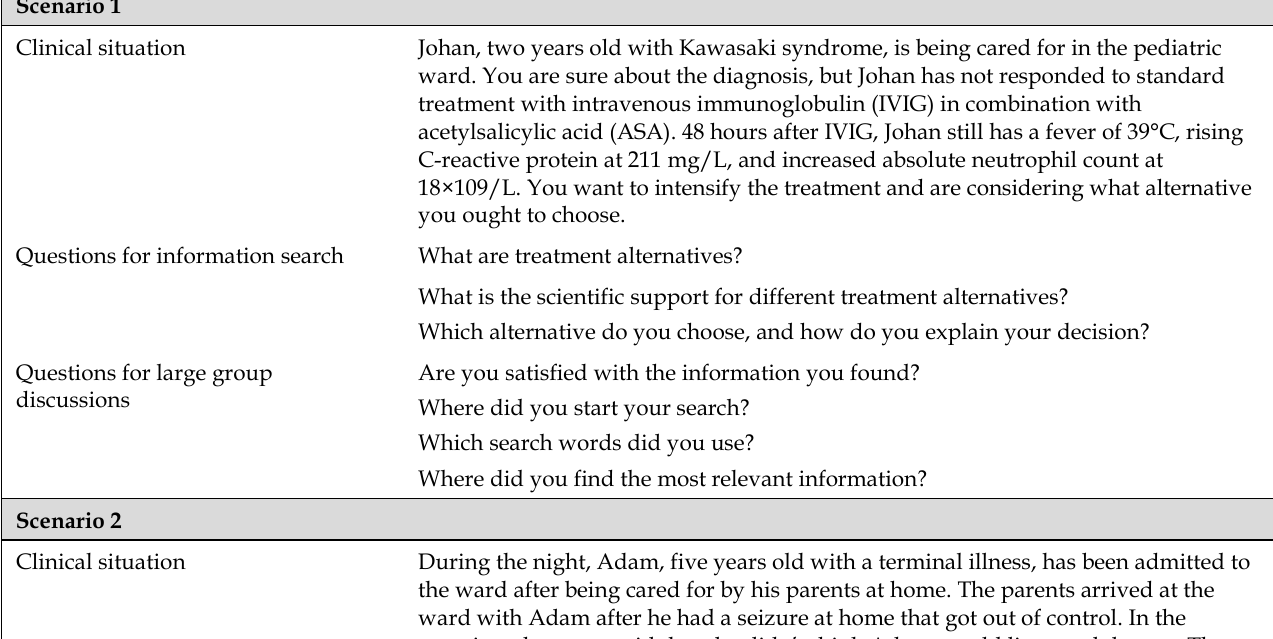
Table 1 Examples of scenarios used during the workshop Scenario 1 Clinical